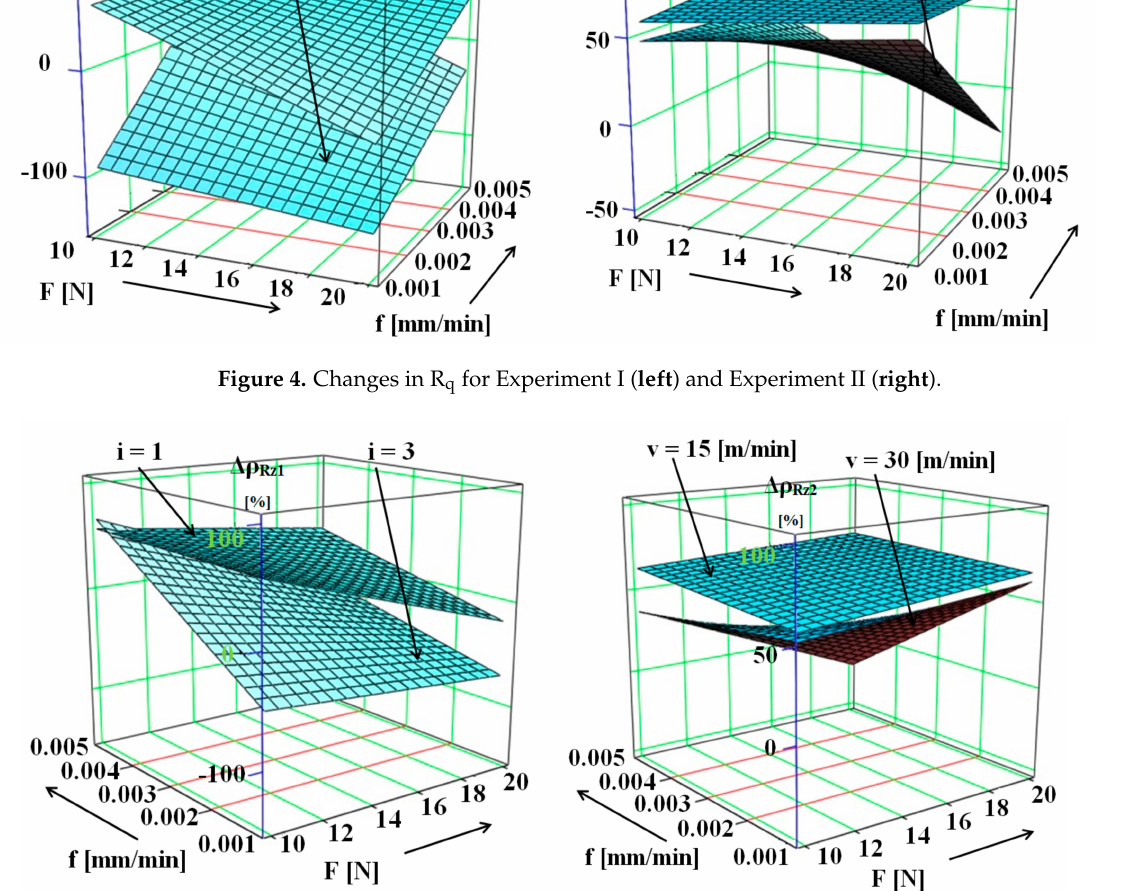
Figure 5. Changes in R z for Experiment I ( left ) and Experiment II ( right ).